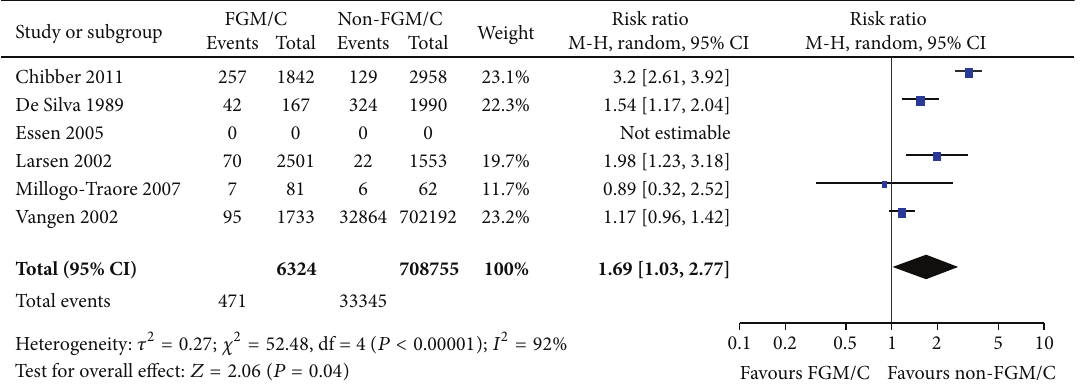
Figure 2: Forest plot, prolonged labor. Note: Sensitivity analyses for outcome (prolonged labor stage) and study type were not statistically significant. Data were missing in Ess´en et al. [36], and we did not succeed in obtaining data from the authors; thus, results from this study are not